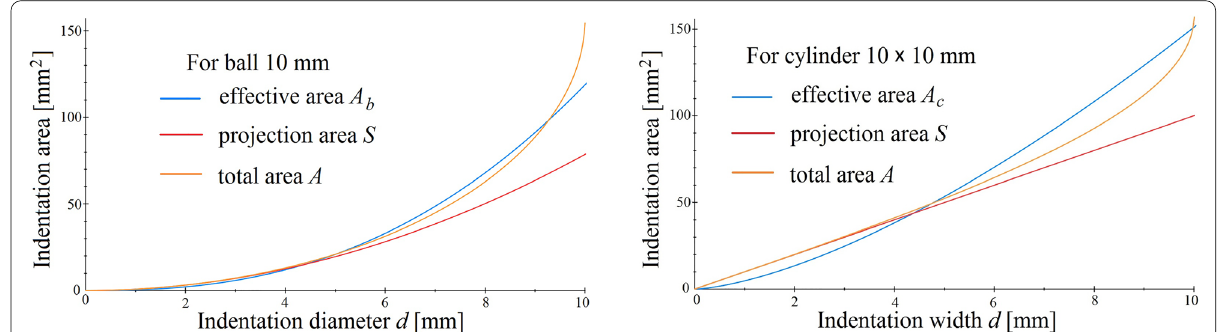
Fig. 8 Charts of dependence of three types of indentation areas S , A and A b or A c on indentation width d . On the left for the ball and on the right for the cylinder ( D L 10 = =